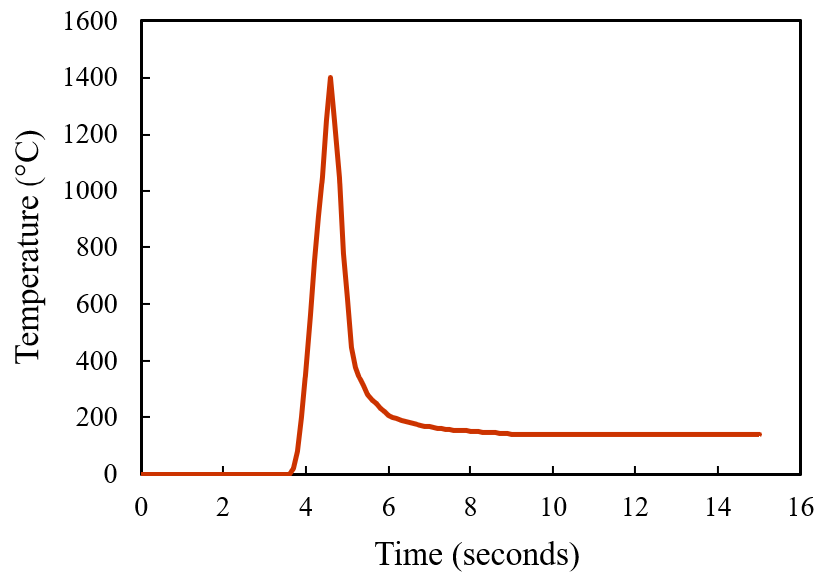
Figure 14. A typical laser thermal profile used as the laser surface hardening temperature input in simulation.